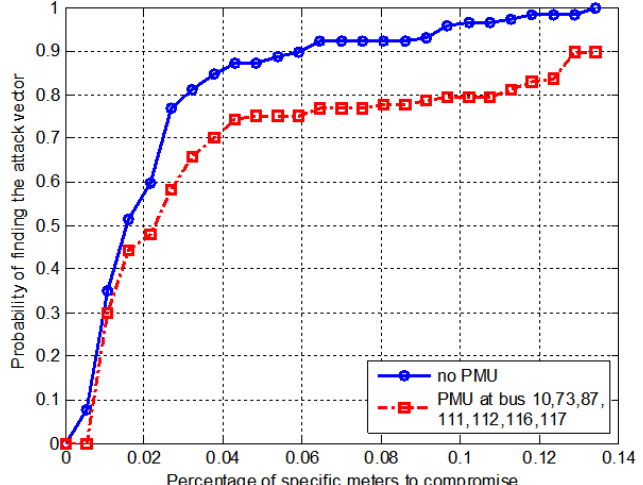
Figure 7. IEEE 118-bus system.